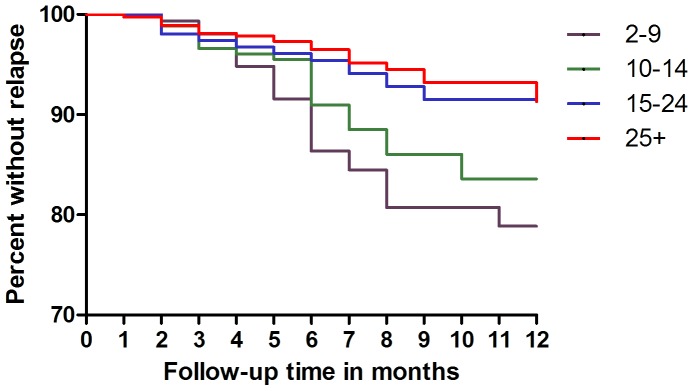
Kaplan-Meier Survival plot for relapse per age group.